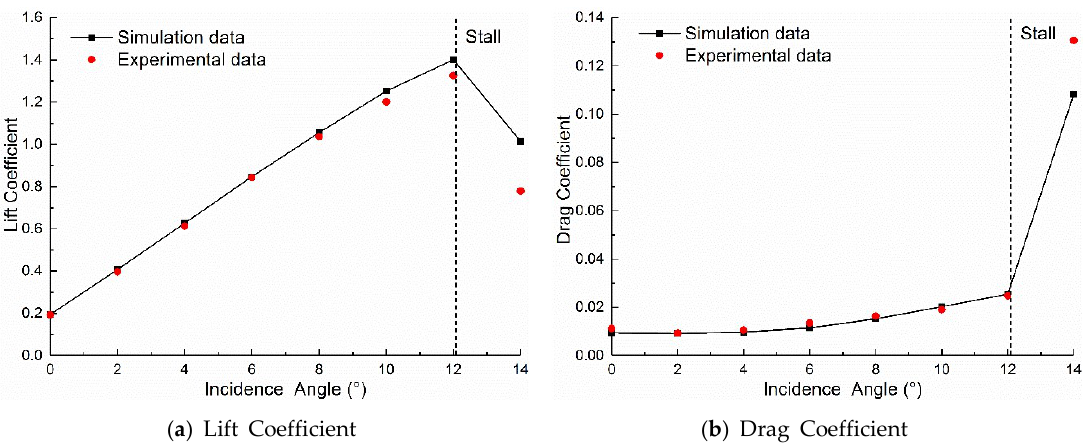
Figure 4. Comparison of the simulated and experimental data with rainfall.